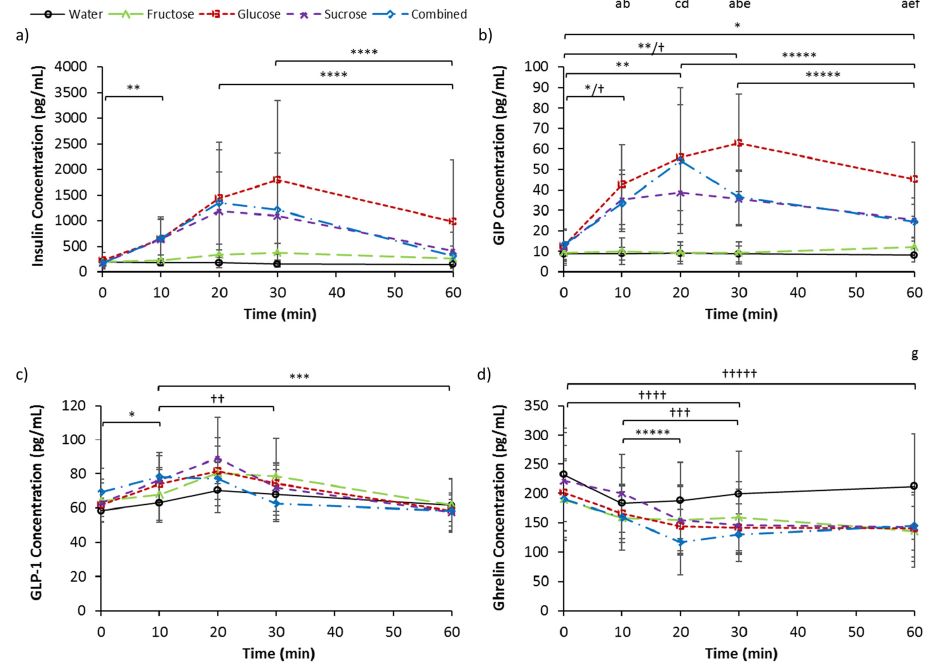
Figure 2. Serum ( a ) Insulin ( b ) glucose dependent insulinotropic polypeptide (GIP) ( c ) glucagon like peptide-1 (GLP-1) and ( d ) ghrelin concentrations at baseline and following ingestion of 595 mL of water (W), 6% fructose (F), 6% glucose (G), 6% sucrose (S) and 6% combined glucose and